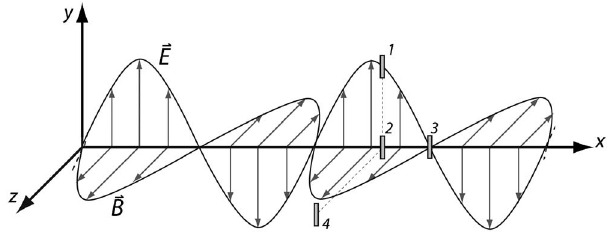
FIG. 3. EM wave as presented on the post-test in both the initial and follow-up studies. Vertical antennas are